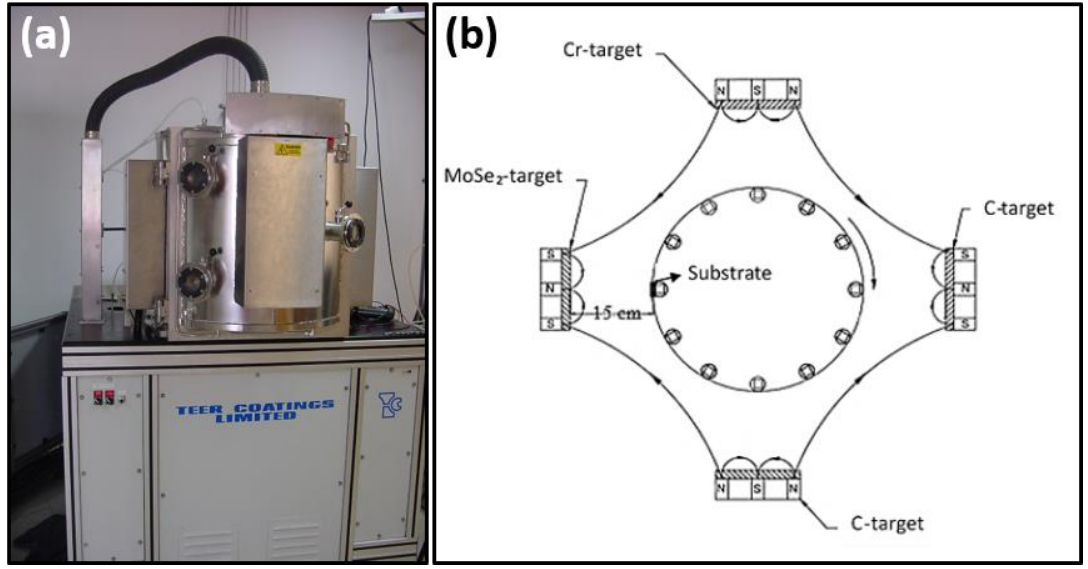
Figure 2. Closed-field unbalanced magnetron sputtering equipment: ( a ) External view; ( b ) Schematic picture from the targets inside the chamber. Table 3. Coating parameters used for MoSeC